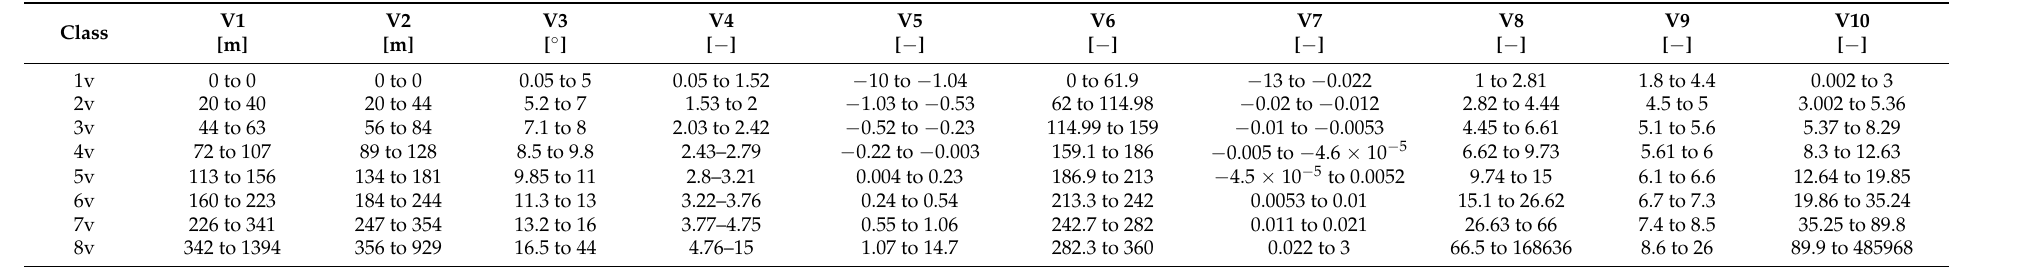
Table 3. Classification of the independent variables employed in the statistical analyses carried out at Vaglio Basilicata.